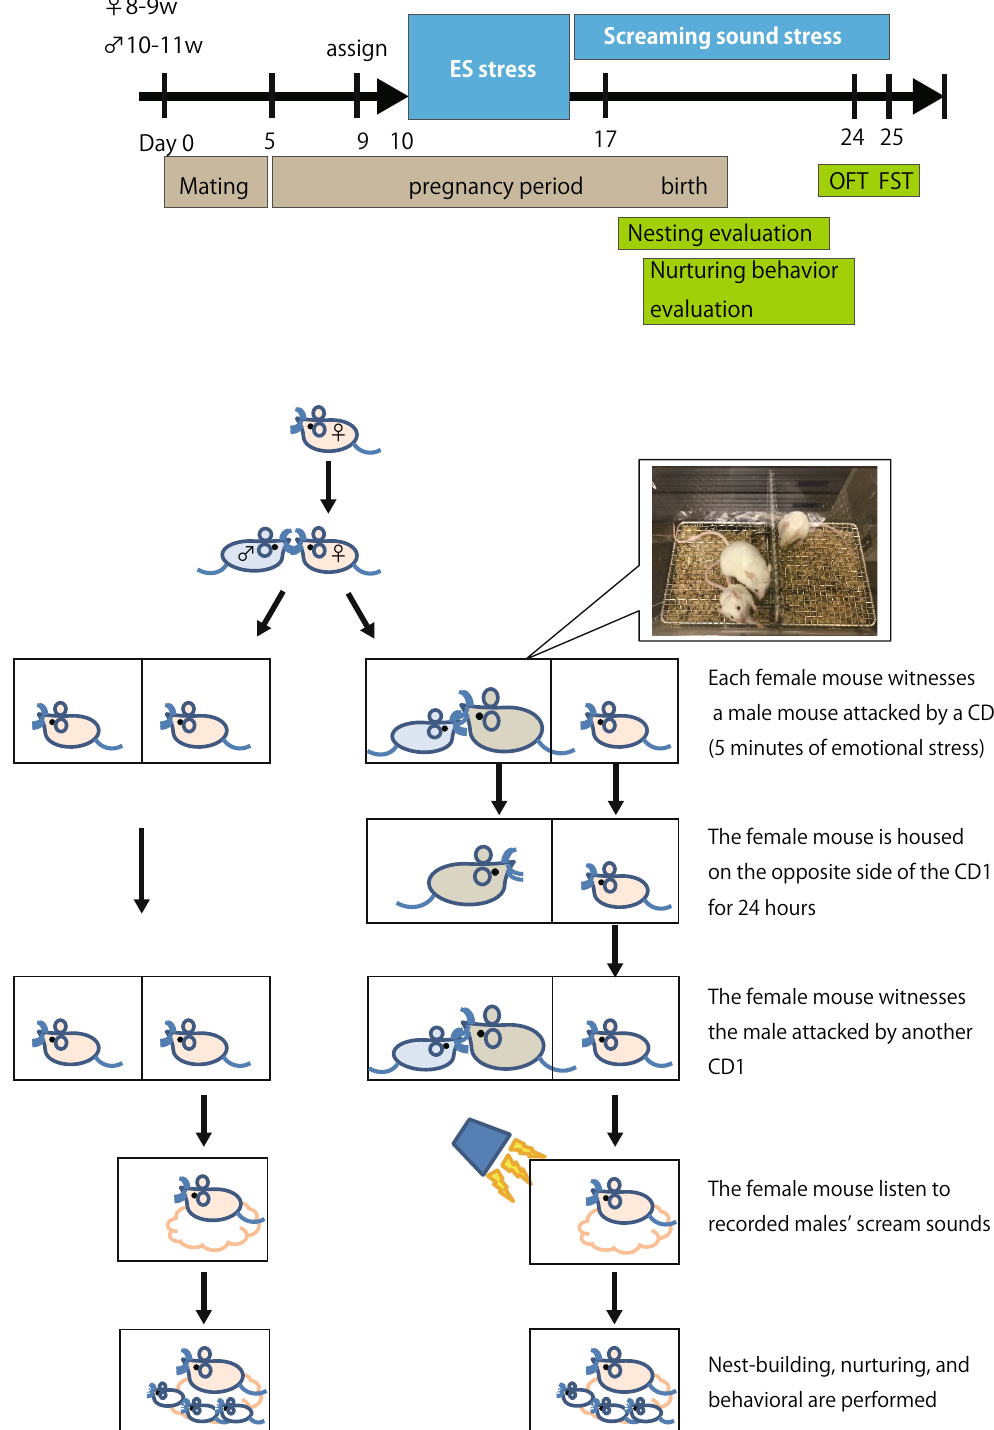
Figure 5. Procedure for the behavioral experiments. Female mice were housed together for mating (day 0). On day 5, the females were kept individually in a stress cage. Each female mouse witnessed a male mouse being attacked by a CD1 aggressor for 5 min on the other side of the cage. Following the fights, the female mouse was housed on the opposite side of the CD1 aggressor for 24 h. This session was repeated over 7 consecutive days. The female mouse was transferred to a normal cage and listened to recorded male mouse vocalizations during fighting for 10 h per day from day 17 to day 25. Nest building behavior was evaluated from day 19. The open field test (OFT) and forced swim test (FST) were performed on days 24 and 25,